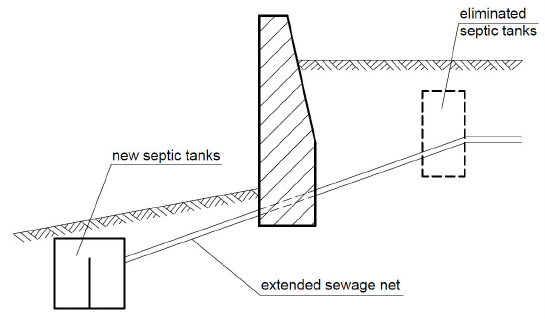
Fig. 13. New concept of the sewage system